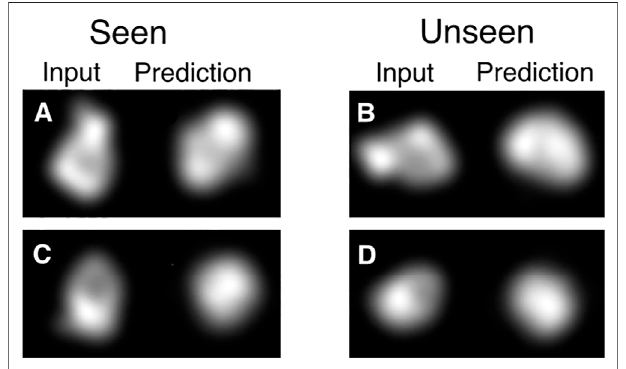
FIGURE 2 | Demonstration of information sharing between different poses with the CNN. HOLLy was stopped half-way through the fi rst epoch of training, meaning only half of the data has been used for training. Note that for the half of the data which has been seen, this corresponds to a single stepofgradientdescentper image,and halfofthedatahasnotyetbeenused atall.Alreadyitcanbeobservedthatinmanycasesonseendata(illustratedin A, C ) there is correspondence between the input and output shapes (albeit imperfect as it is very early in the optimization process). The advantage of the CNN can be observed in the results on unseen data where this correspondence also exists (B, D) . This partial convergence on unseen data shows that the CNN allows earlier data to assist in the convergence of data seen later, which provides a very substantial improvement over modelling poses